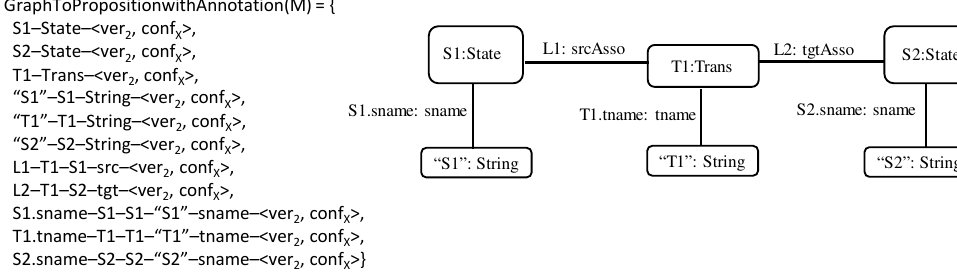
Figure 13. GraphToPropositionWithAnnotation encoding of model M in Figure 12.